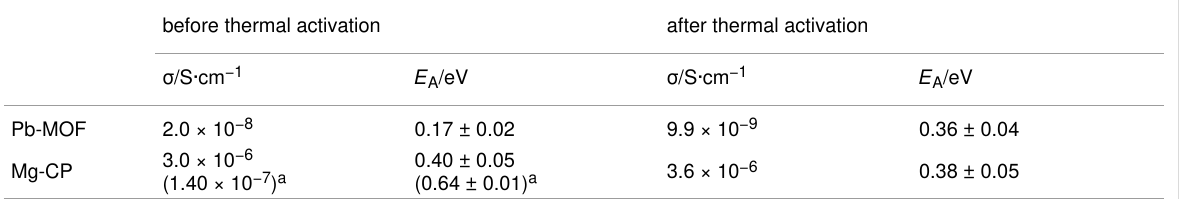
Table 1: Proton conductivity of [Mg(H 2 O) 2 (H 3 L)]·H 2 O (Mg-CP) and [Pb 2 (HL)]·H 2 O (Pb-MOF), before and after thermal